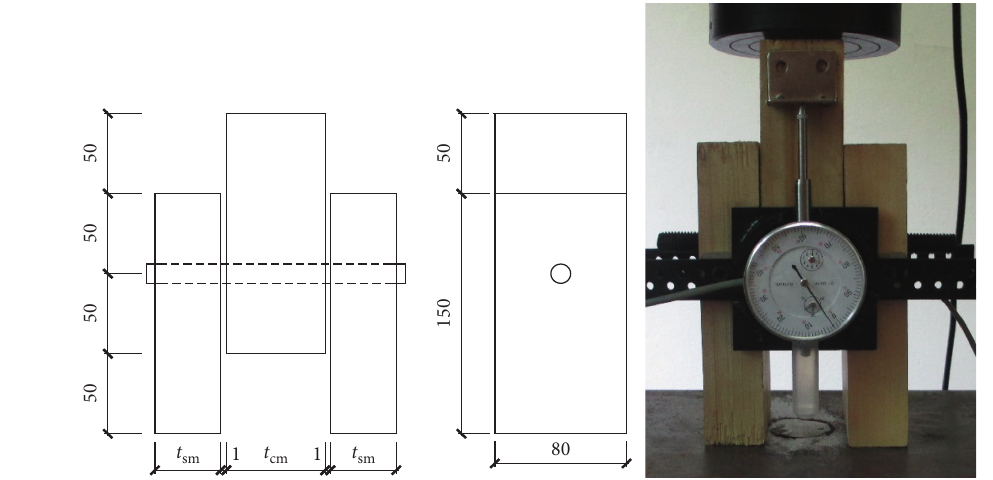
Figure 4: Bolted wood connection. Table 4: Thickness combinations for bolted wood